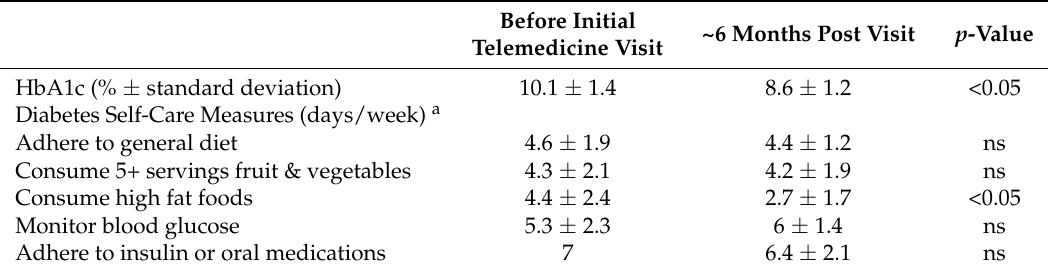
Table 2. Diabetes